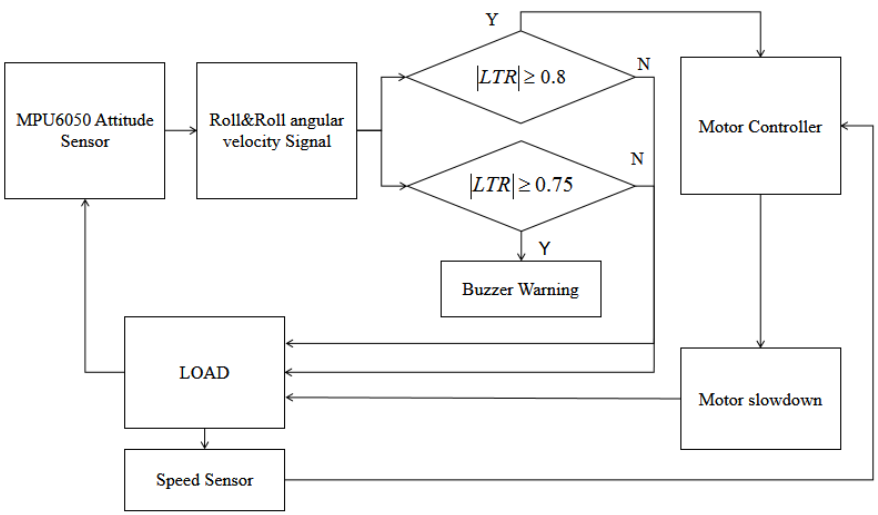
Figure 2. Rollover control strategies.